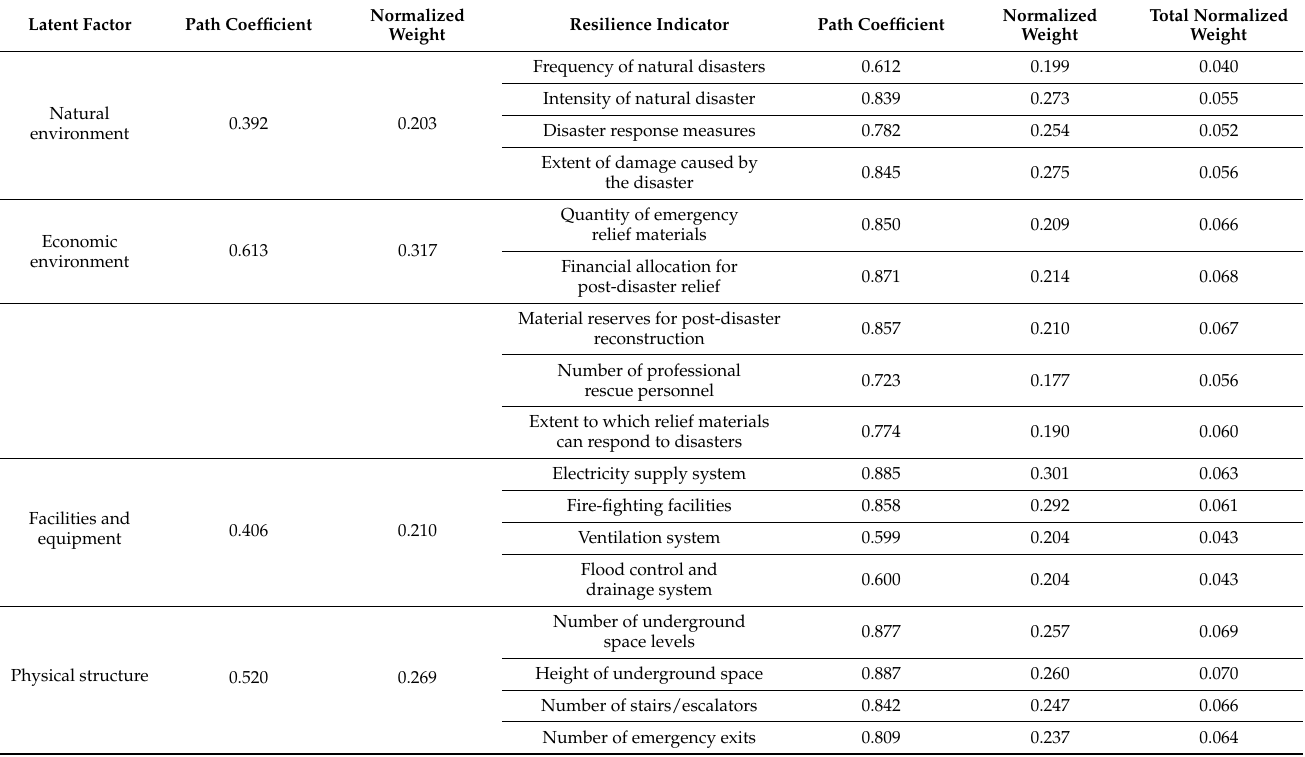
Table 14. Path coefficients and normalized weights of latent factors and resilience